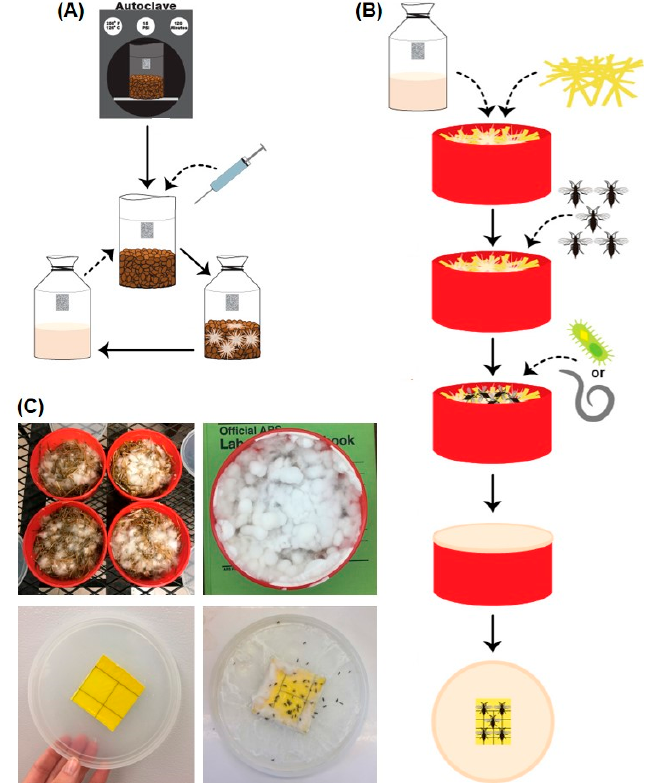
Figure 2. Infographic demonstrating the bioassay methods used to test the effect of incorporating Bacillus thuringiensis var. israelensis and Steinernema feltiae into straw substrate inoculated with Pleurotus spp. on the emergence of fungus gnats ( Lycoriella sp.). Solid lines indicate processes and dashed lines indicate added elements. ( A ) The process of preparing rye berry ‘spawn’ consisted of substrate sterilization, inoculation with a Pleurotus spp. spore syringe, and incubation for mycelium colonization. Two spawn bags were prepared to inoculate all 30 substrate containers within each bioassay. ( B ) The process of preparing the bioassay containers consisted of mixing colonized rye berries and pasteurized straw in bioassay containers, infesting with fungus gnats, incorporating biological control agents ( Bti or S. feltiae ), and entrapping emerged adults. Ten substrate containers per treatment were prepared for each bioassay for a total of 30 containers. ( C ) Bioassay containers with inoculated straw and sticky cards affixed to the lids with entrapped adult fungus